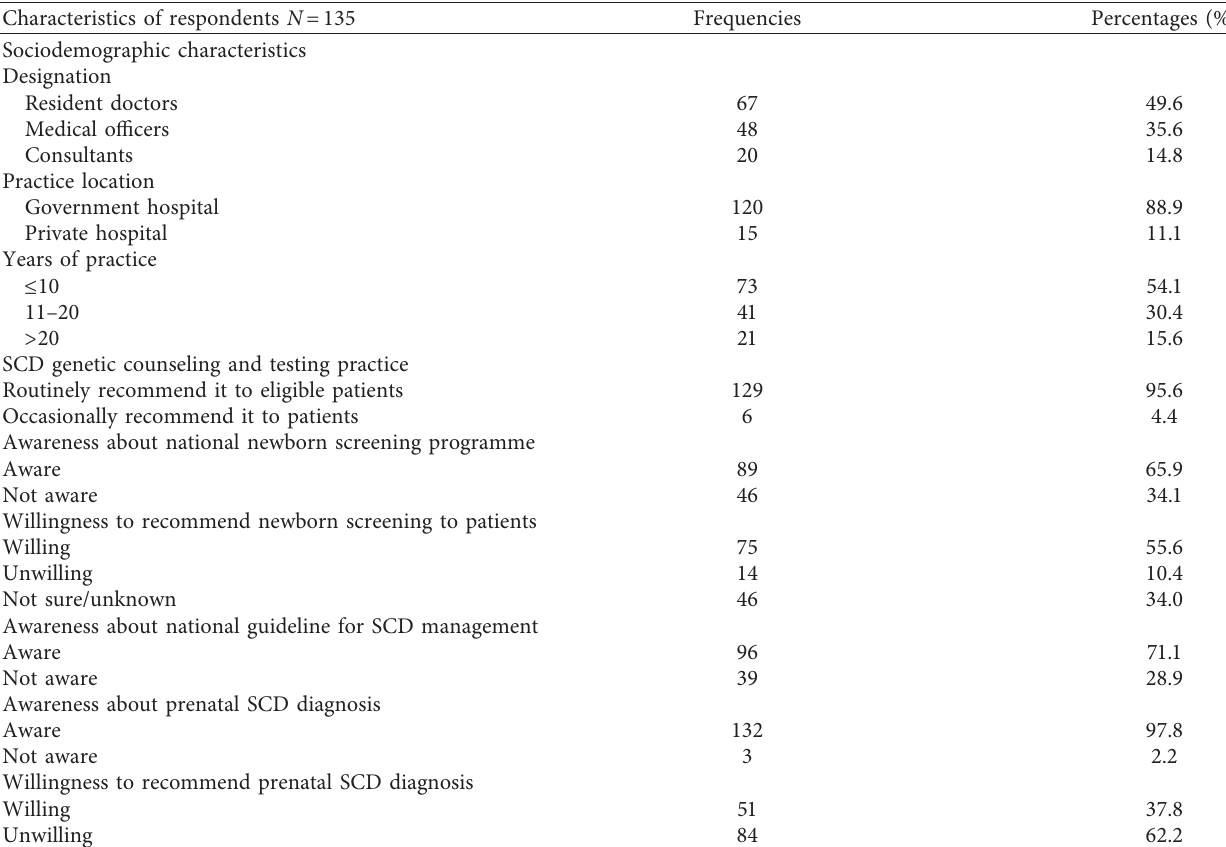
Table. 1: Sociodemographic characteristics, practice of early diagnosis, and awareness of the national treatment guidelines for sickle cell disease among physicians Characteristics of respondents N �